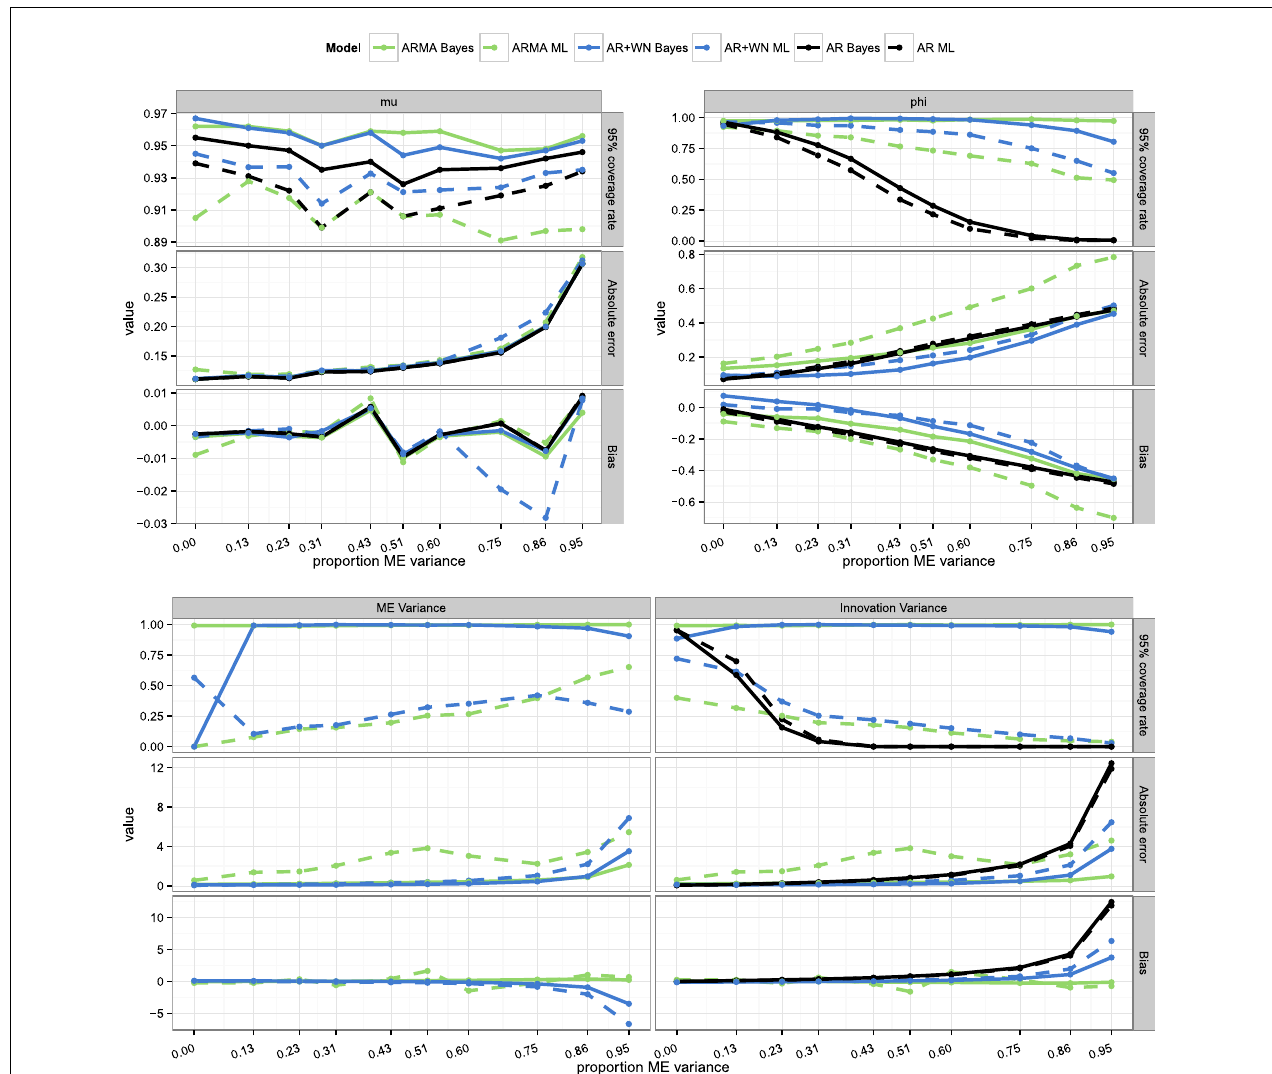
FIGURE 2 | Coverage rates, absolute errors, and bias for the parameter estimates for the frequentist and Bayesian AR(1), ARMA(1,1), and AR(1) + WN models across different proportions of measurement error variance to the total variance.